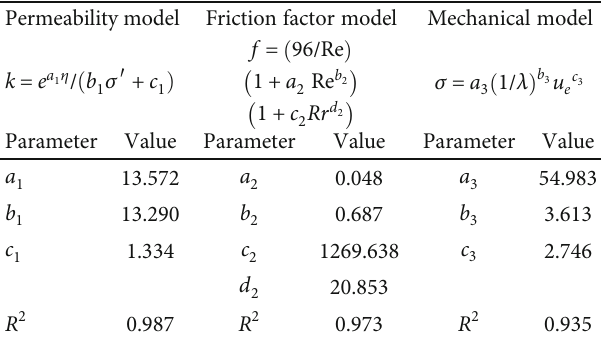
Table 5: Fitting results using equations (11), (32), and (35). Permeability